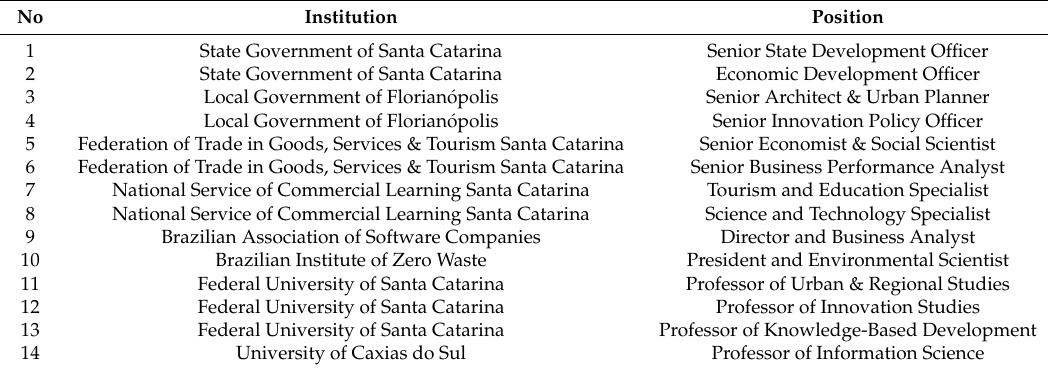
Table 1. Profiles of the interview